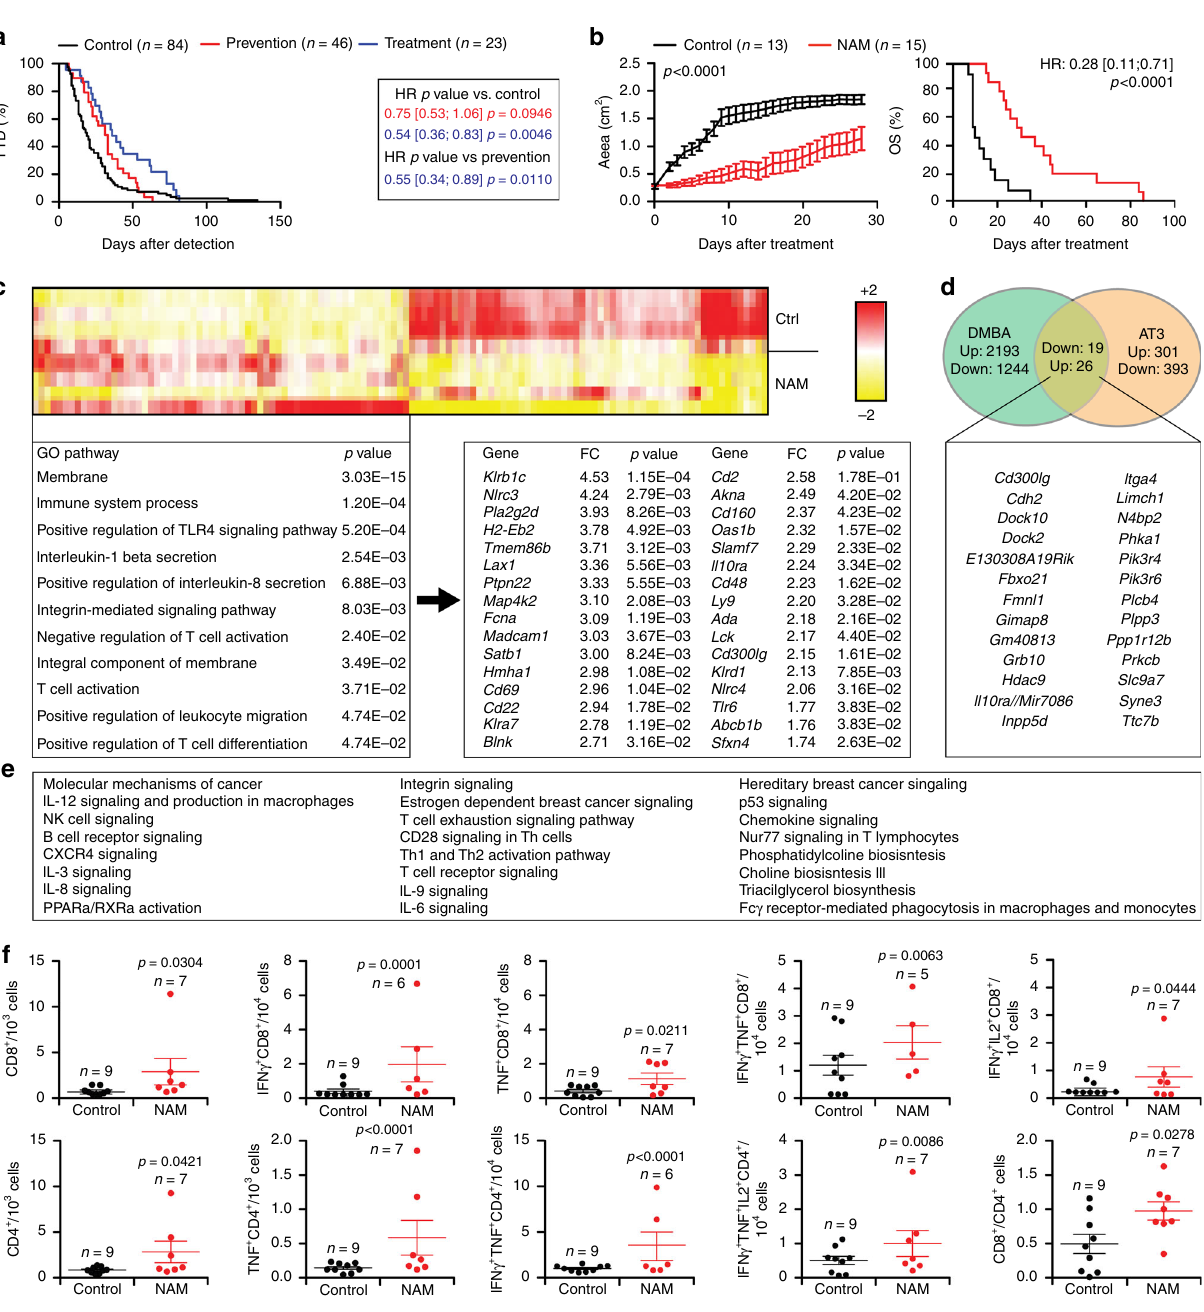
Fig. 6 NAM mediates immunotherapeutic effects on established BCs. a Time-to-death (TTD) of C57BL/6 mice subjected to M/D-driven carcinogenesis in control conditions or in the context of NAM supplementation with the drinking water, either from MPA pellet implantation (prevention) or tumor detection (treatment). Number of mice, hazard ratio (HR) and p values (two-sided log-rank) are reported. b Tumor growth and overall survival (OS) in C57BL/6 mice bearing established M/D-driven tumors that were maintained in control conditions or subjected to NAM supplementation with the drinking water. Tumor growth results are means ± SEM. Number of mice, HR and p values (two-way ANOVA corrected for row (time) and column (treatment) factors for tumor growth and two-sided log-rank for OS) are reported. c Non-supervised hierarchical clustering of genes differentially expressed in untreated ( n = 4) vs NAM-treated ( n = 4) M/D-driven tumors. Top upregulated genes, fold change (FC) and adjusted, two-sided p values are reported. Gene Ontology analysis and adjusted, two-sided p values for enrichment are indicated. d Comparison of private vs shared transcriptional changes induced by NAM treatment in M/D-driven tumors vs AT3 tumors established in C57BL/6 mice. The list of genes upregulated by NAM in both models is provided. See also Supplementary Fig. 3g. e Ingenuity Pathway Analysis of genes upregulated by NAM in both M/D-driven tumors AT3 tumors established in C57BL/6 mice. f Immune in fi ltration of AT3 tumors established in C57BL/6 mice that were maintained in control conditions or received NAM supplementation with the drinking water (starting at tumor detection) for 10 days. Results are means± SEM plus individual data points. Number of mice and p values (one way-ANOVA plus Fisher LSD) are